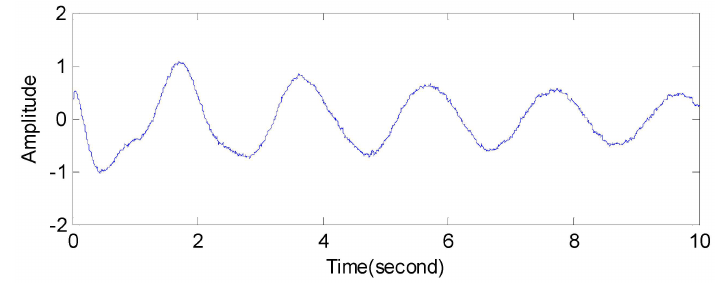
Figure 12. The simulated signal with colored noise after low-pass filtering.